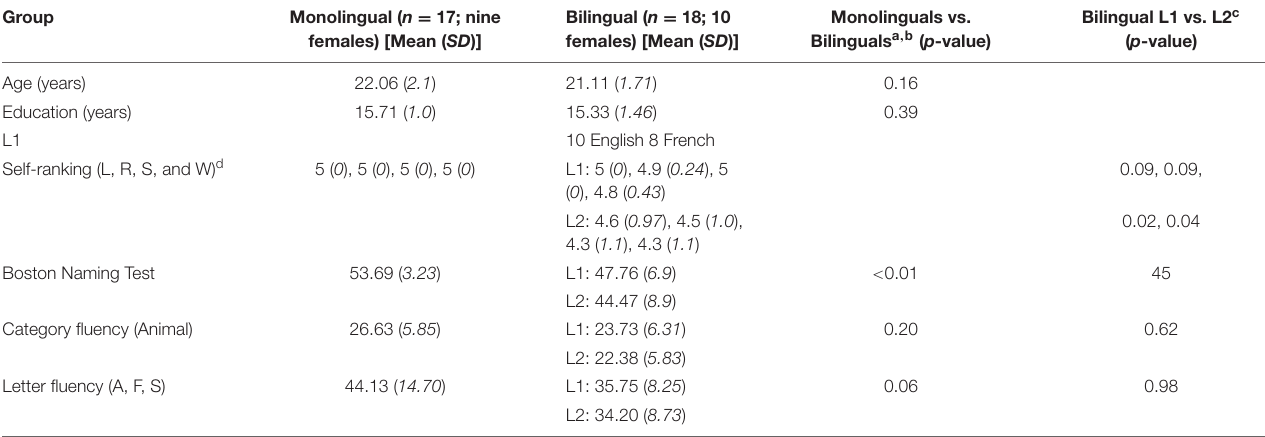
TABLE 1 | Demographic and language performance information in monolinguals and bilinguals. Group